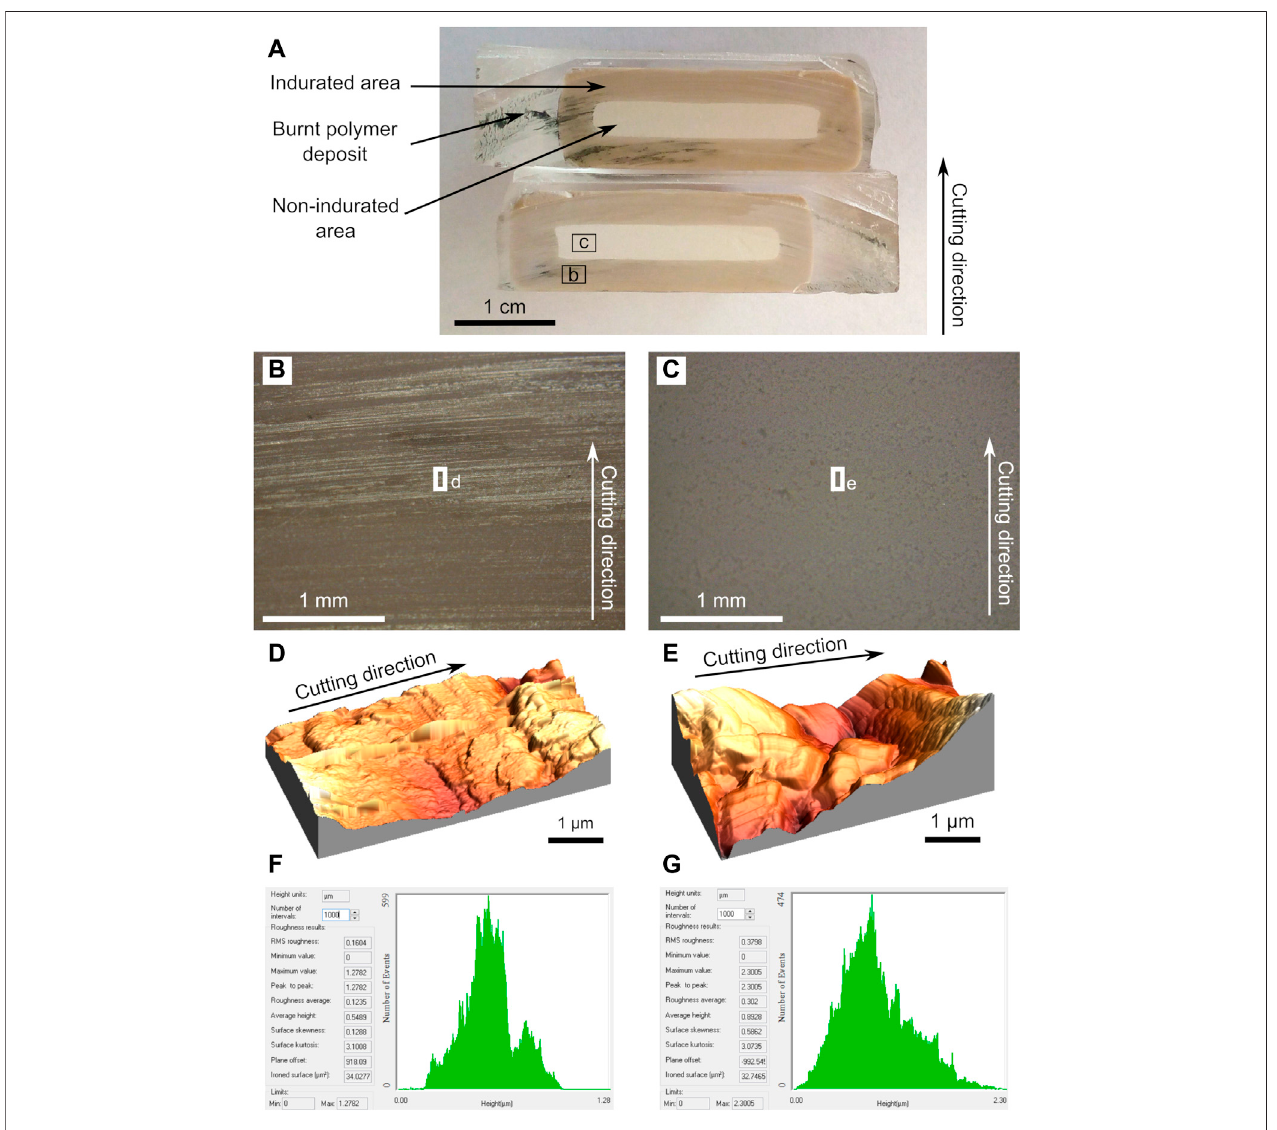
FIGURE 6 | Chalk sample after cutting test on Presi P100 disc saw. (A) Image of the cut surface. (B,C) Optical microscopy images in re fl ected light of the areas indicated in (A) . (D,E) AFM images of the areas indicated in (C,D) respectively and (F,G) associated roughness measurement.